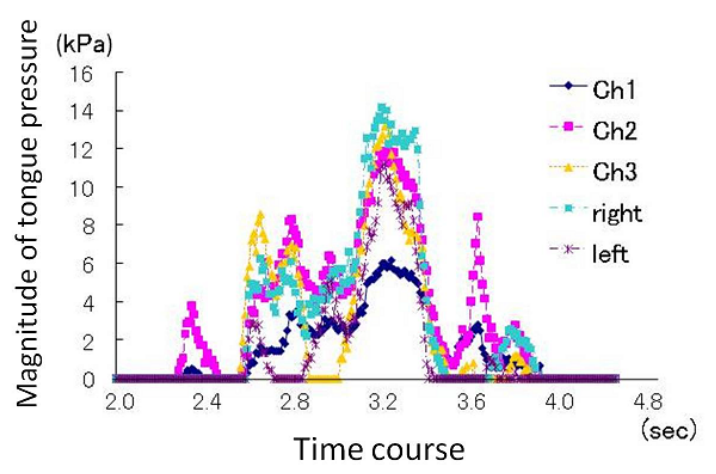
Figure 15. Tongue pressure production during swallowing water in a tongue cancer